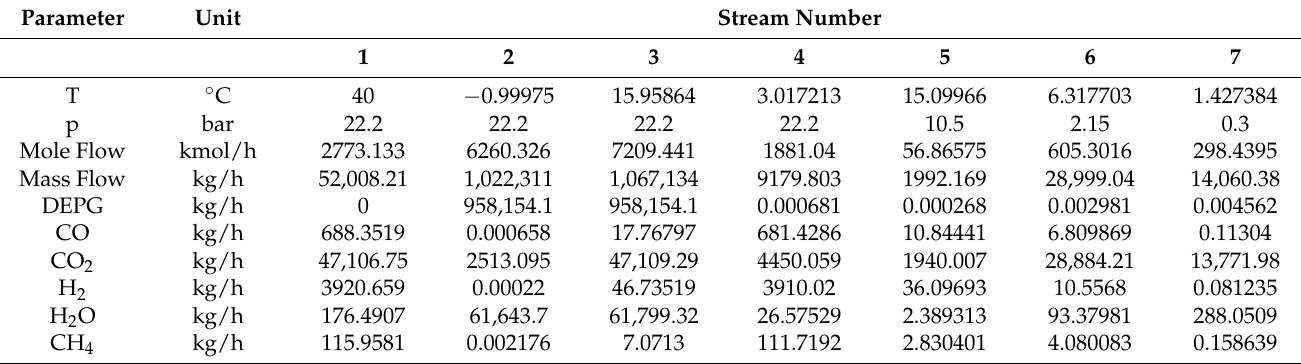
Table A7. Mass/Mole flows of Selexol process for TRIR outlet gas with temperature and pressure state. Parameter